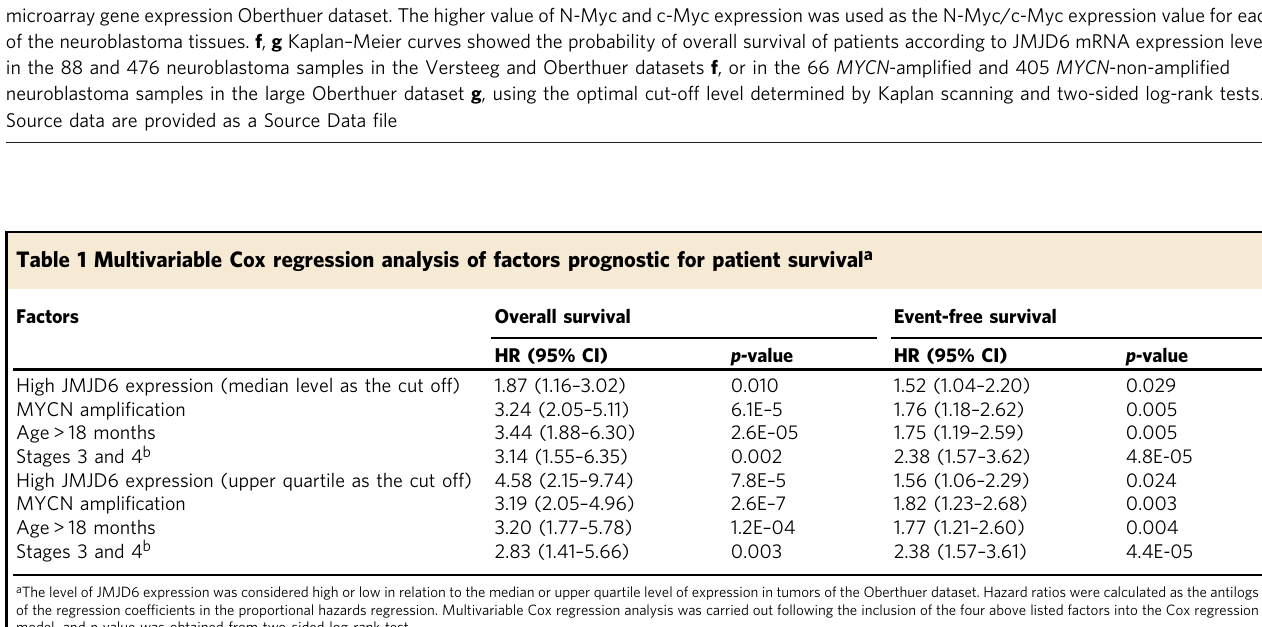
Fig. 1 High JMJD6 gene expression in neuroblastoma tissues predicts poor patient prognosis. a , b Array-CGH data were employed to examine chromosome 17q and JMJD6 gene gain in 209 human neuroblastoma tissues. The frequencies of chromosome gain at different regions of chromosome 17q were plotted against genomic locations in the 209 neuroblastoma tissues a . The Venn diagram showed overlap between JMJD6 gene gain and MYCN gene ampli fi cation or nonampli fi cation in the human neuroblastoma tissues b . c , d Chromosome 17q copy number ( c ) and JMJD6 gene expression ( d ) were examined among the 209 human neuroblastoma tissues according to 17q segmental gain, numerical gain, or no gain. JMJD6 gene expression was obtained from the Kocak